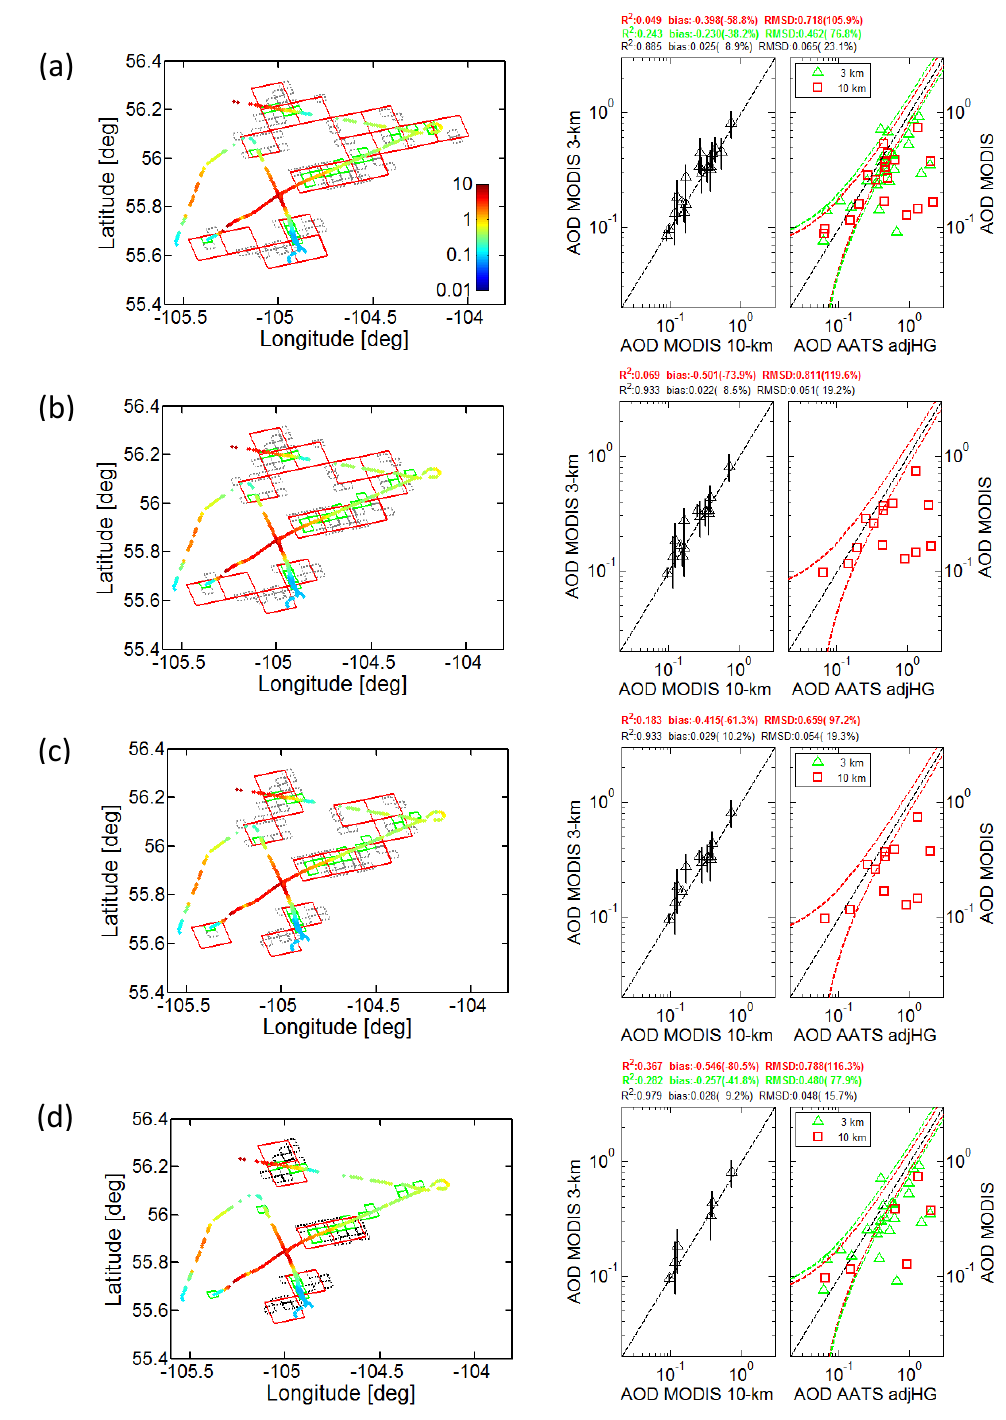
Figure 7. For 02 July: map overlays and MODIS 3-km/10-km and MODIS/AATS AOD scatterplot results for different values of the MODIS retrieval quality flag for the MODIS operational AOD retrievals: (a) QF≥0, (b) QF≥1, (c) QF≥ 2, (d) QF=3. Retrievals at 3-km resolution have been omitted from the scatterplots in (b) and (c) for clarity, because 23 of 25 3- km retrievals yielded QF=3 and the remaining two yielded QF=0.